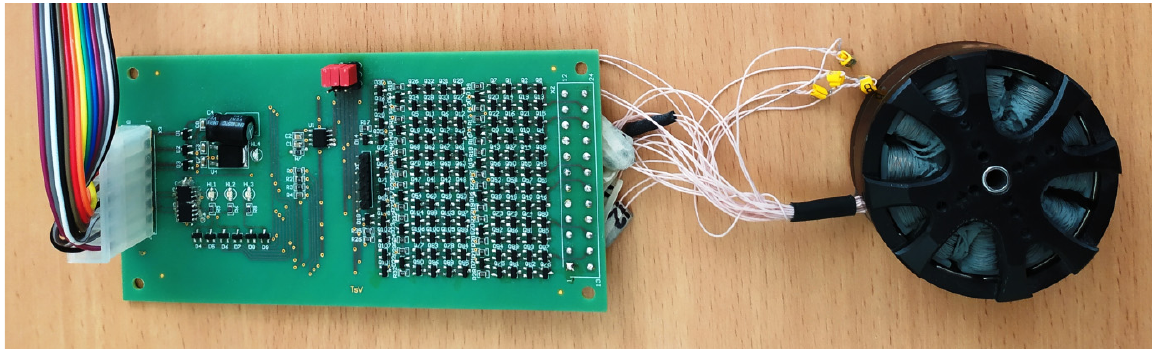
Figure 9. The realization of the electronic switch.